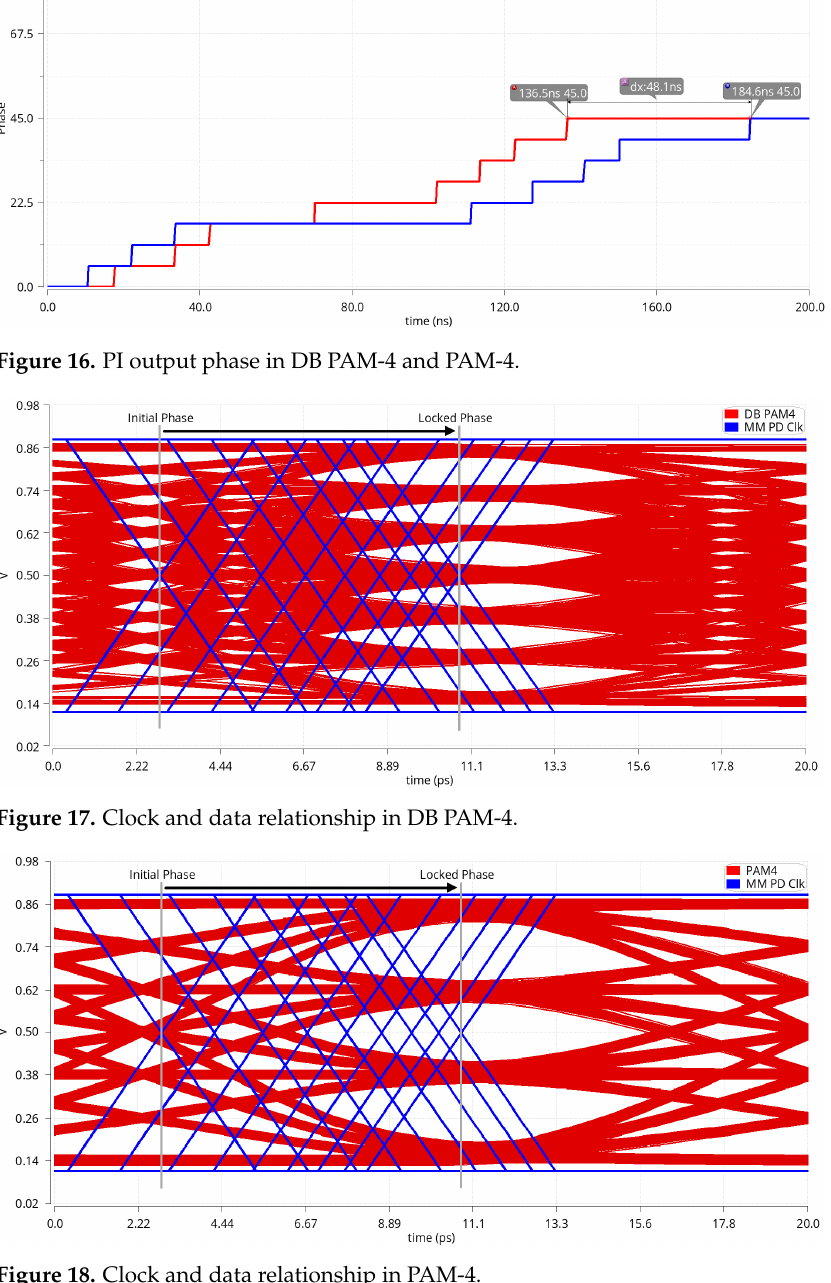
Figure 18. Clock and data relationship in